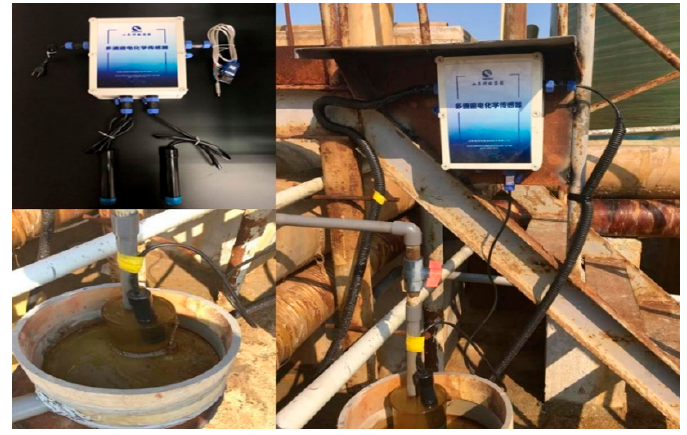
Figure 13. Multi-parameter electrochemical sensor working in the factory.